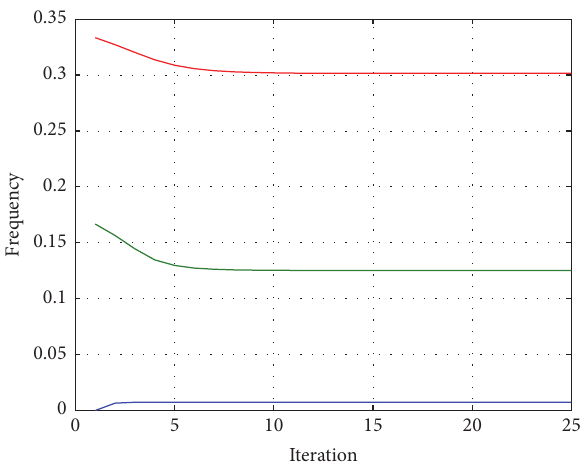
Figure 4: Center frequencies changing during VMD iteration.